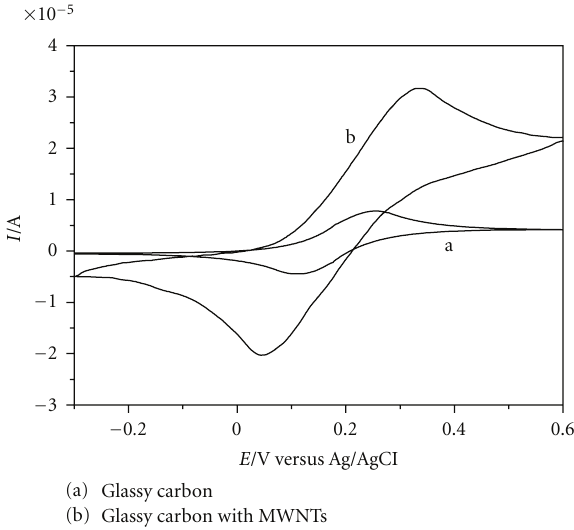
Figure 6: Voltamperometric profiles corresponding to a glassy carbon electrode (GCE): (a) without, and (b) with